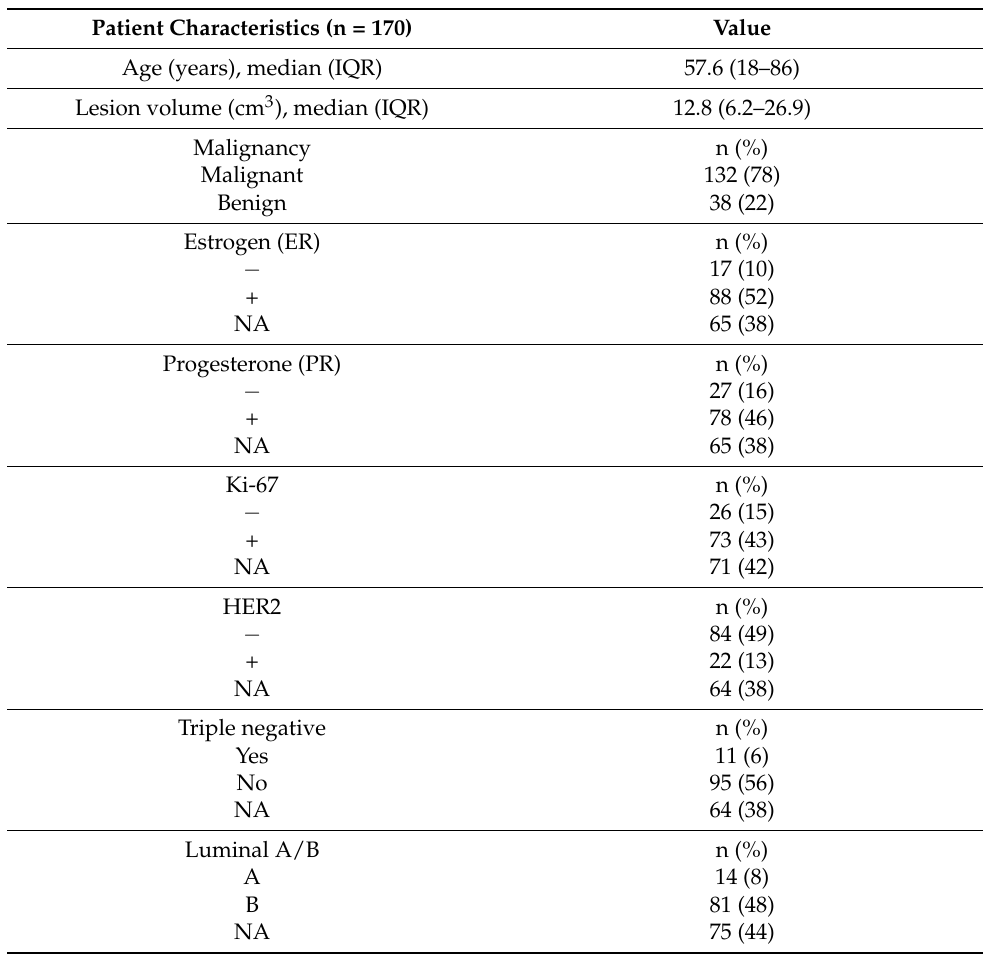
Table 1. Patient cohort characteristics for malignancy, estrogen (ER), progesterone (PR), human epidermal growth receptor 2 (HER2), Ki-67 protein expression, triple negative, and luminal A/B status. NA = Not